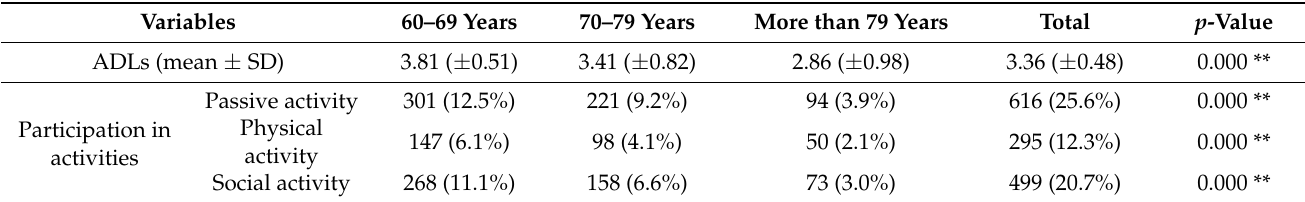
Table 4. Participation in activities among older